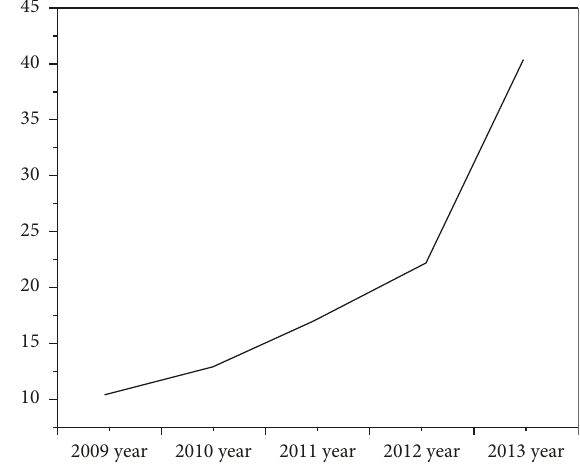
Figure 4: Growth rate of global 3D printing market